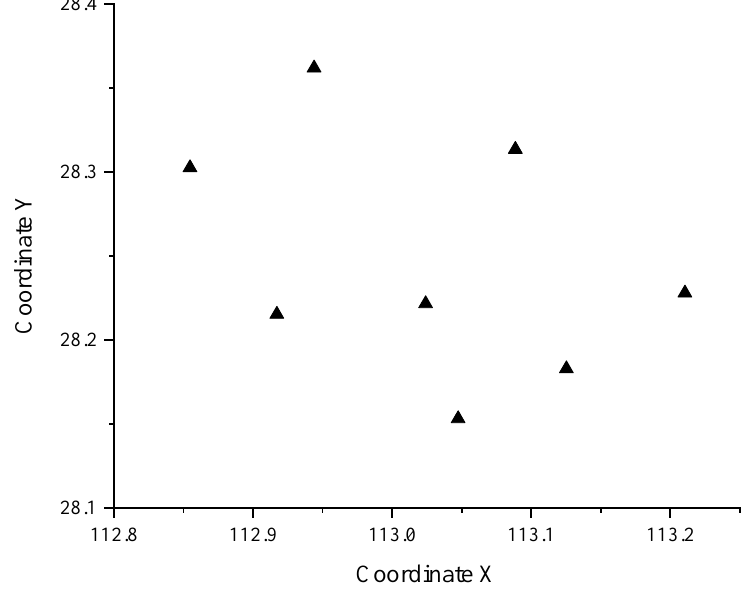
Figure 6. Enterprise established networks in Changsha City.